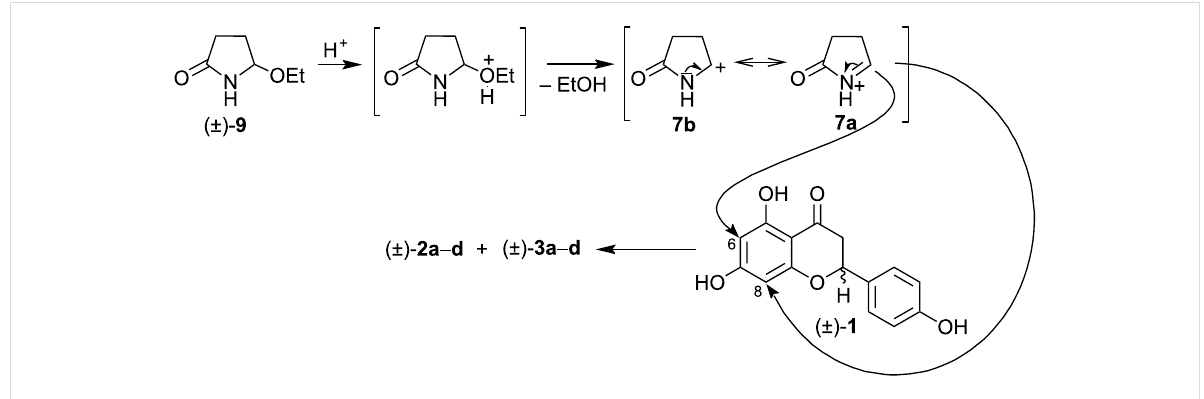
Figure 14: Proposed mechanism for the formation of dracocephins A and B ( 2a – d and 3a – d ) starting from (±)- 9 .